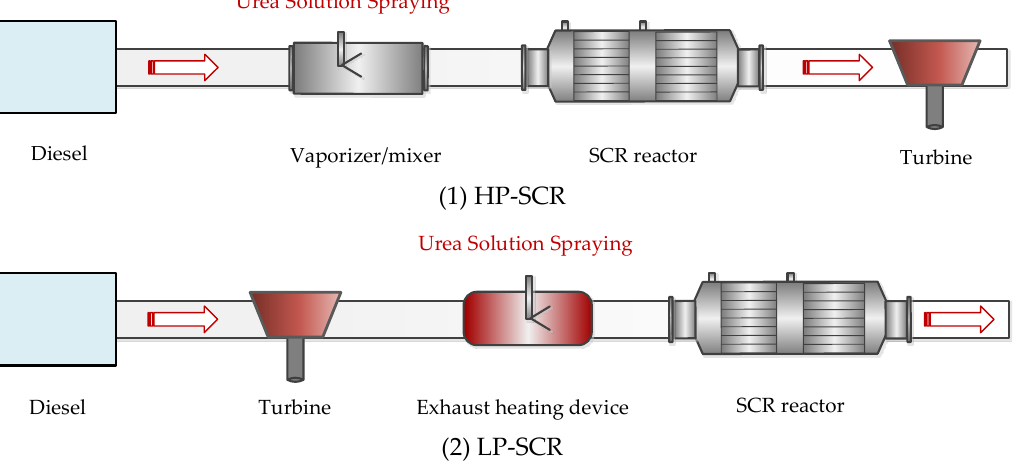
Figure 1. Flowchart of the marine diesel engine high-pressure SCR system and low-pressure SCR system [ 9 ].